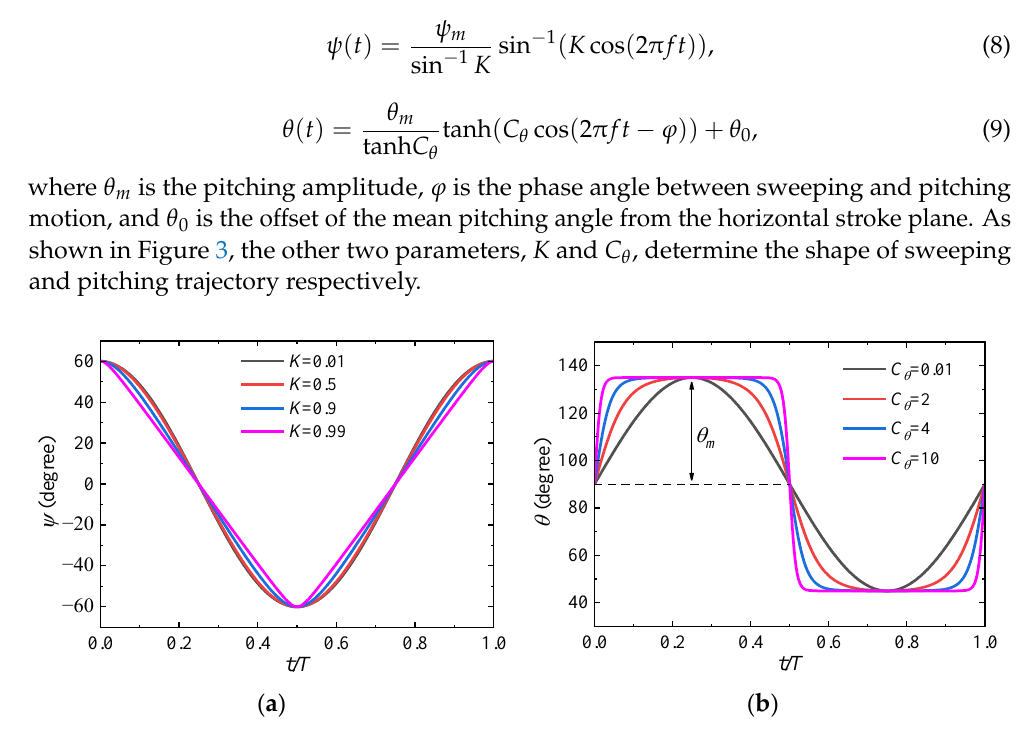
Figure 2. Definition of the flapping angle variables. ( a ) Schematic diagram of the sweeping and pitching motion and coordinate systems. ( b ) Definition of the angle of attack α and rotation angle θ . The red dot means the leading edge. The black arrow line represents the flapping direction.